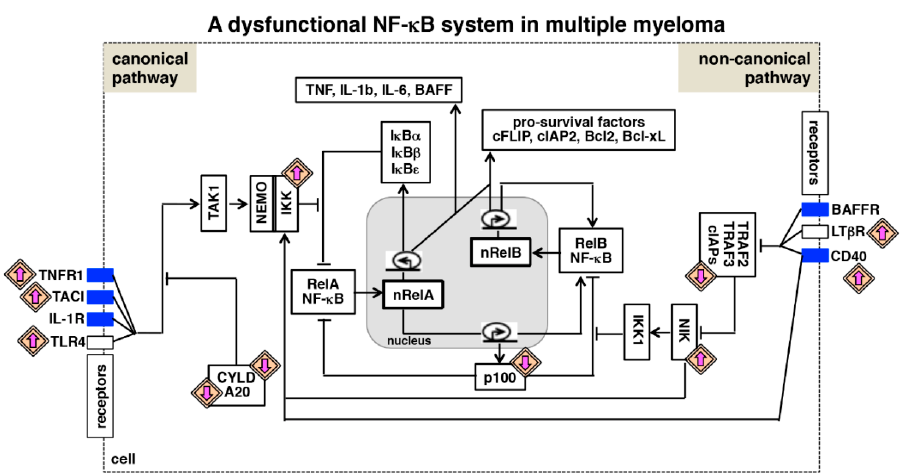
Figure 3. A dysfunctional NF- κ B system in multiple myeloma. Various biochemical mechanisms interlink NF- κ B-activating canonical and non-canonical pathways within an integrated NF- κ B system. Also in myeloma cells, RelA and RelB containing dimers mediate expressions of overlapping set of anti-apoptotic genes. Multiple myeloma is associated with the gain-of-function mutation (upward directed purple arrow) of genes encoding NF- κ B activators and the loss-of-function mutation (downward directed purple arrow) of genes encoding inhibitors of the NF- κ B system. In addition, tumor microenvironment-derived factors trigger aberrant activation of cytokine receptor signaling (blue rectangle) in myeloma cells. As such, genetic and microenvironmental factors activate both the NF- κ B activating pathways, and interdependent regulation of these pathways promotes pathological NF- κ B activity and reinforces NF- κ B-driven expressions of pro-survival genes in myeloma